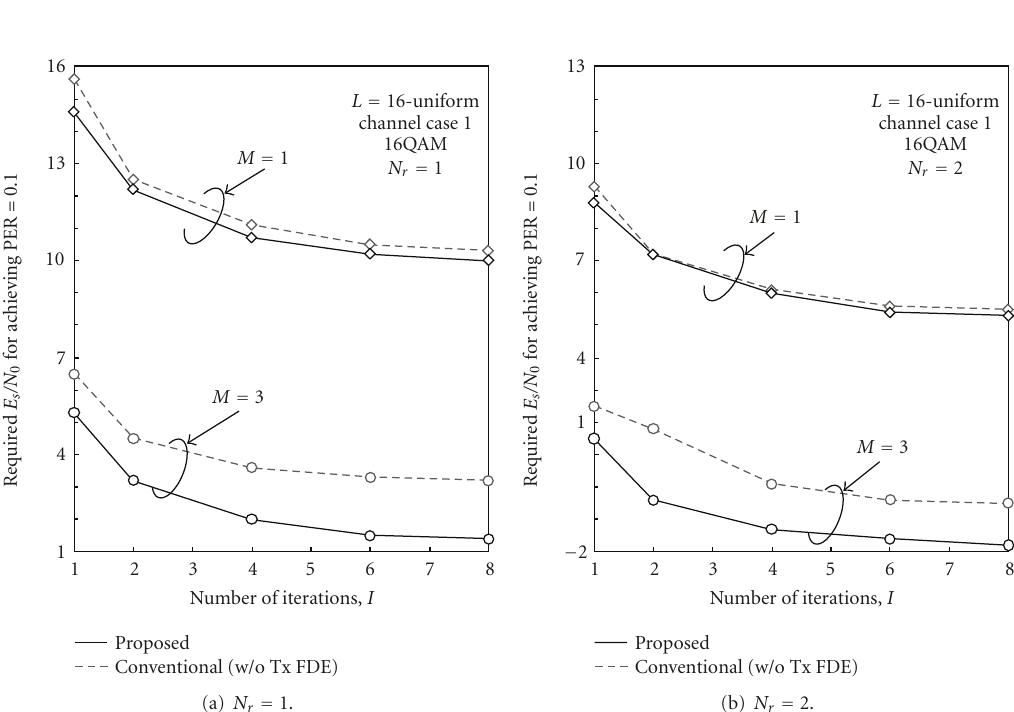
Figure 6: Impact of the number of iterations, I, on required E s /N 0 for achieving PER = 0 .